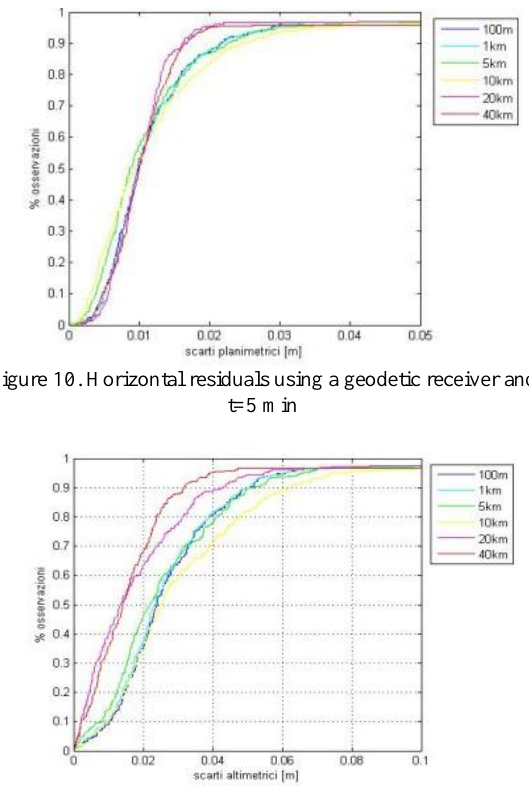
Figure 11. Vertical residuals using a geodetic receiver and t=5 min